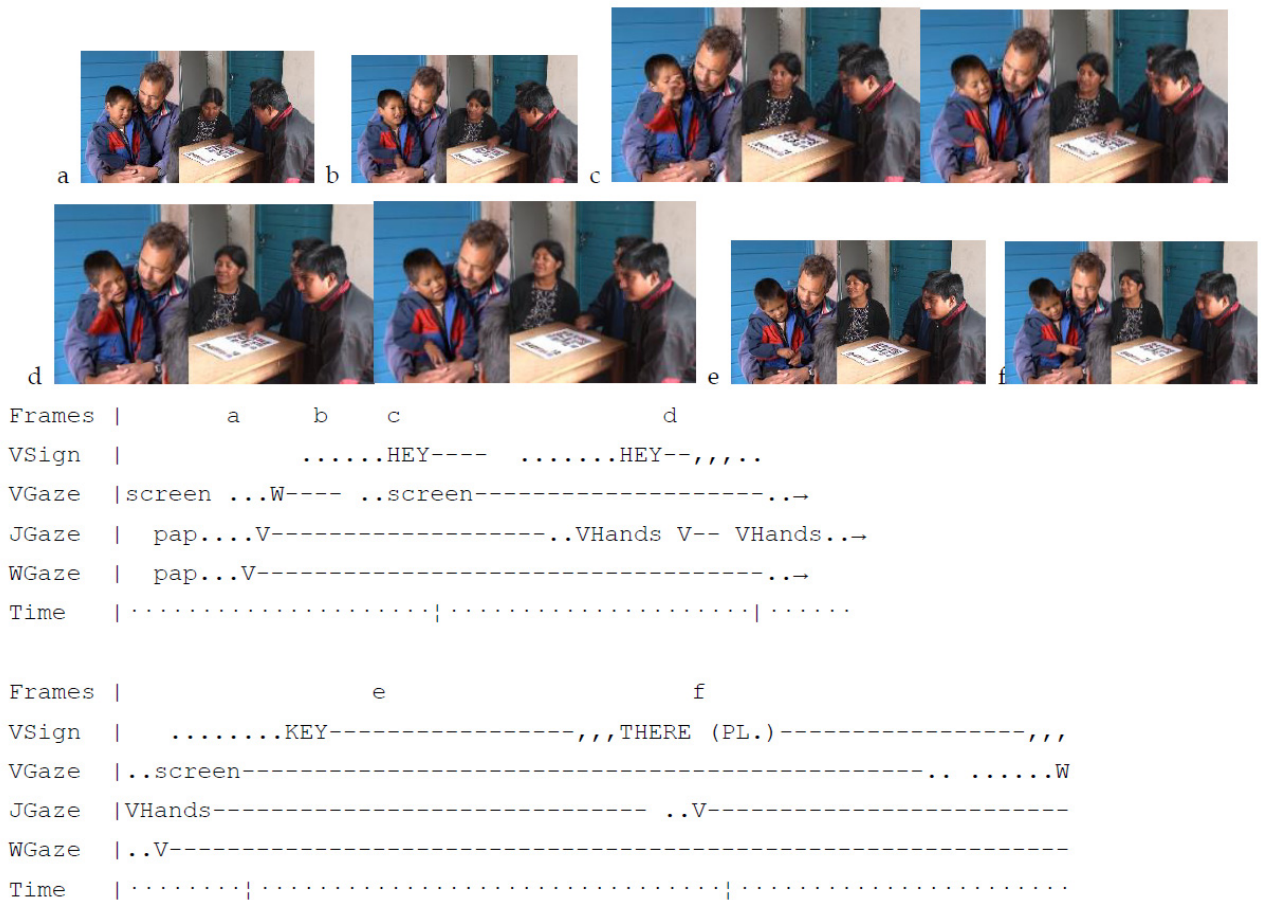
Figure 29. Vic at 4 years and 4 months participated in an eliciting session. ( a ) Vic perused the image as ( b ) the adults began to wait expectantly for him to describe it. He started, however, by ( c ) signing HEY2, ( d ) repeating the sign briefly a second time. Only then did he begin to describe the picture itself by ( e ) mentioning a KEY depicted in it and ( f ) pointing at the computer screen.